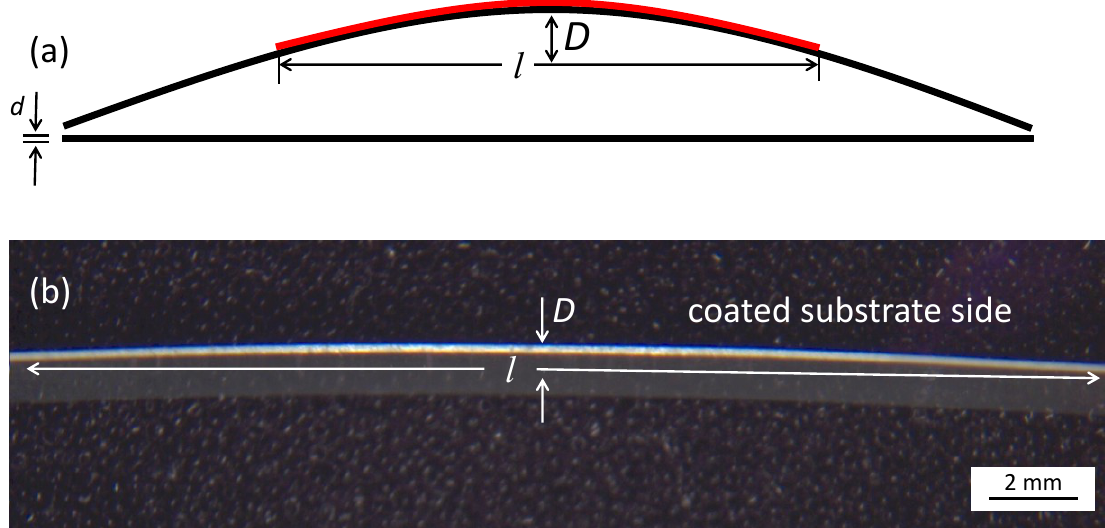
Figure 1. ( a ) Schematic drawing of the flat Al bended one after applying the coating (red); ( b ) typical measurement of bending, D (235 µm), and length, l (19.35 mm), of the layer of a coated substrate. Deposition parameters: 100% He, film thickness t ≈ 4